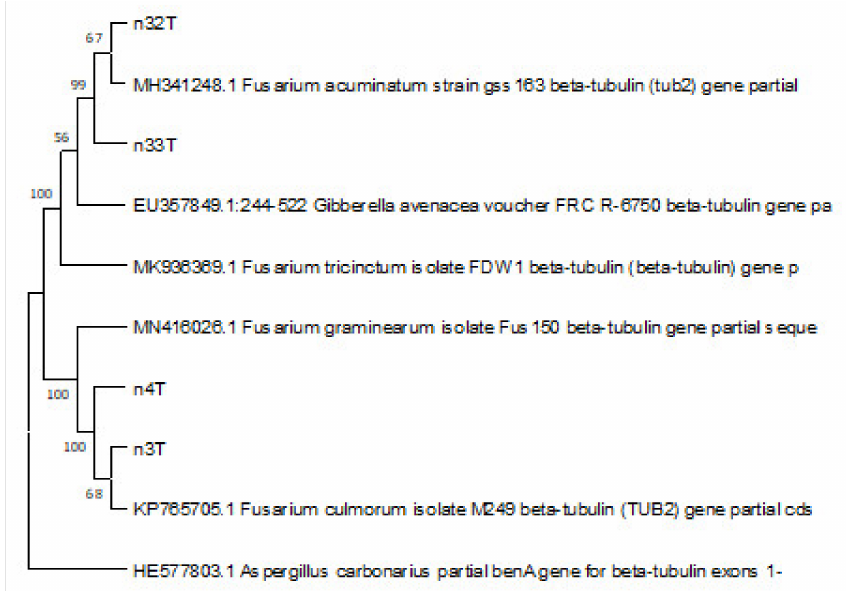
Figure 3. Dendrogram of similarity and difference of β -tub gene fragment sequences of the studied Fusarium species (species name and sample number are given) constructed using the UPGMA method. Stability was determined by bootstrap analysis (100 alternative dendrograms), the percentage of replicate trees in which the associated taxa clustered together in the bootstrap test (100 replicates) are shown next to the branches.